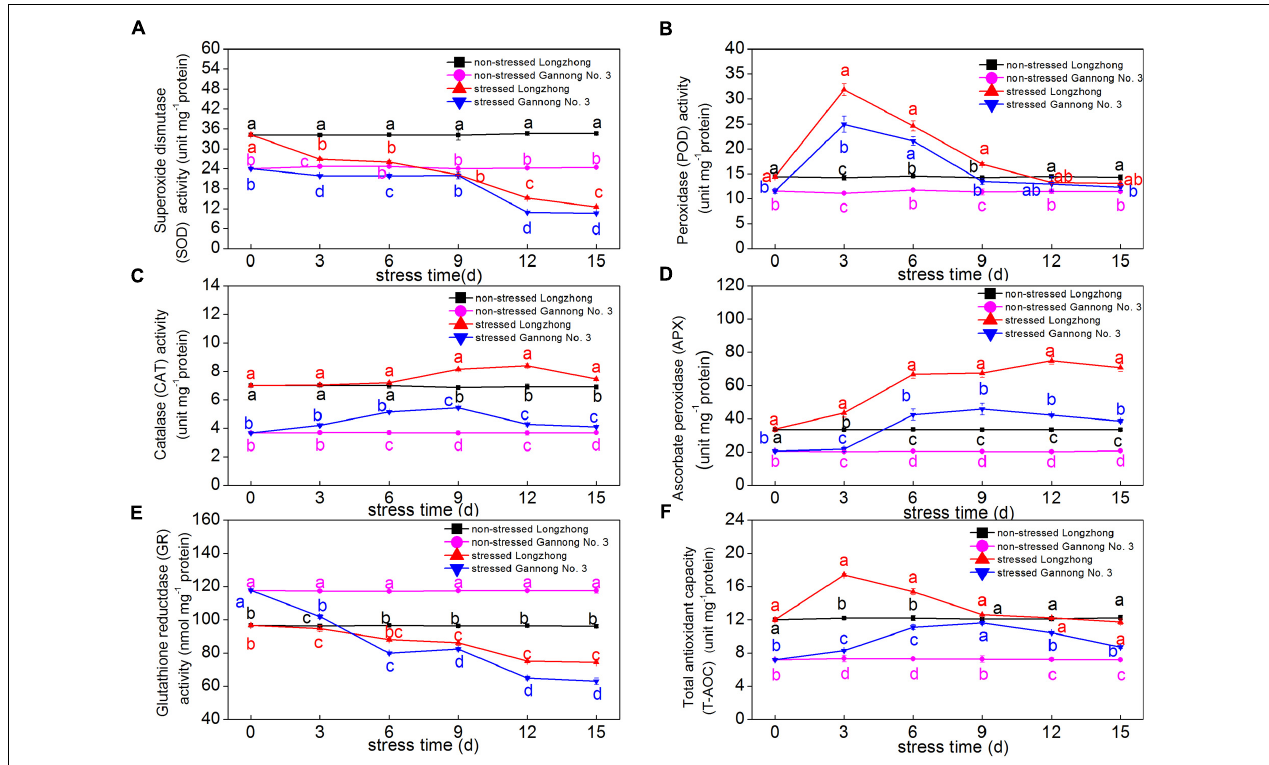
FIGURE 3 | Changes of the activities of antioxidant enzymes (SOD, POD, CAT, APX, and GR) (A–E) and total antioxidant capacity (T-AOC) (F) in two alfalfa varieties under non-stressed and stressed conditions at different time points. Different letters above line graphs indicate significant difference among treatments at a given day of treatment ( P ≤ 0.05), and vertical bars indicate ± SE of mean ( n =